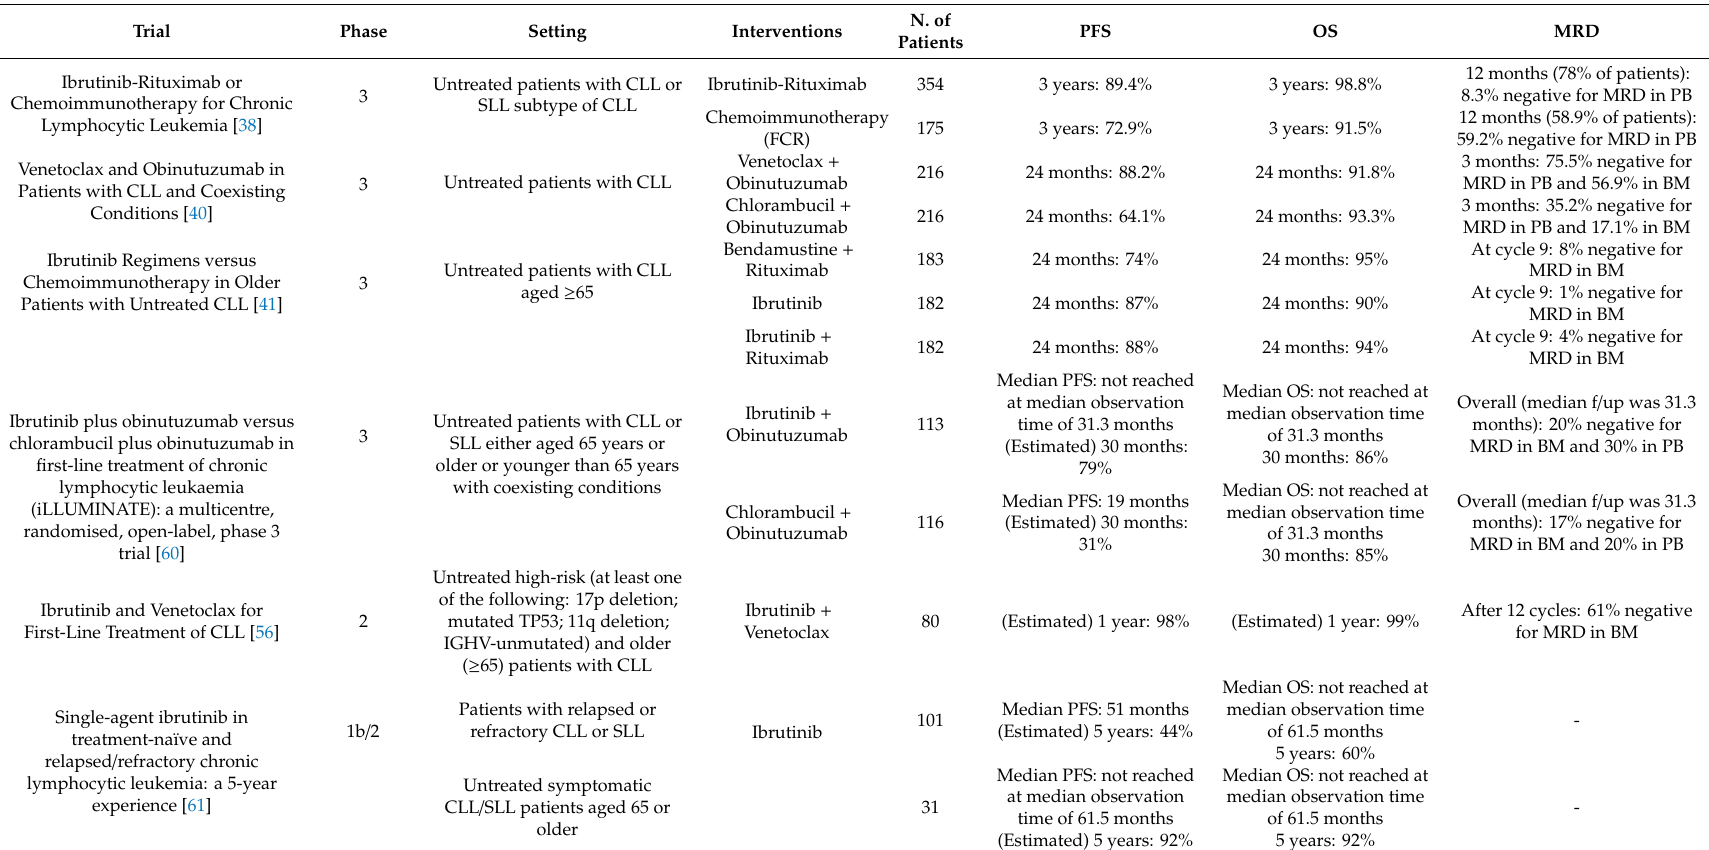
Table 2. Clinical trials in